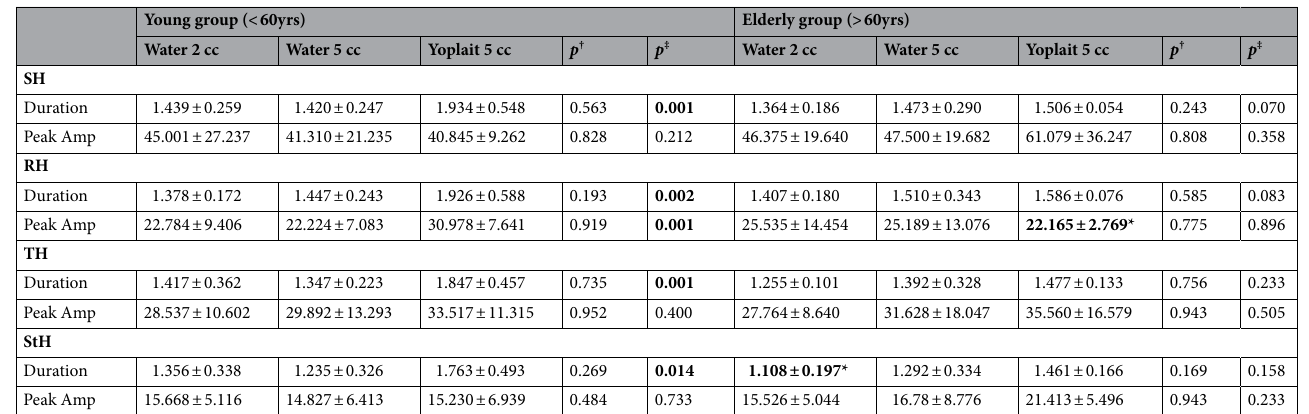
Table 3. Muscle activation duration and RMS values on type I pattern. SH; suprahyoid, RH; retrohyoid, TH; thyrohyoid, StH; sternothyroid, Amp; Amplitude. p † ; p -value between water 2 cc and 5 cc swallowing in same group, p ‡ ; p -value between water 5 cc and yogurt 5 cc swallowing in same group. *: The p -value < 0.05 between young group and elderly group in each food types.